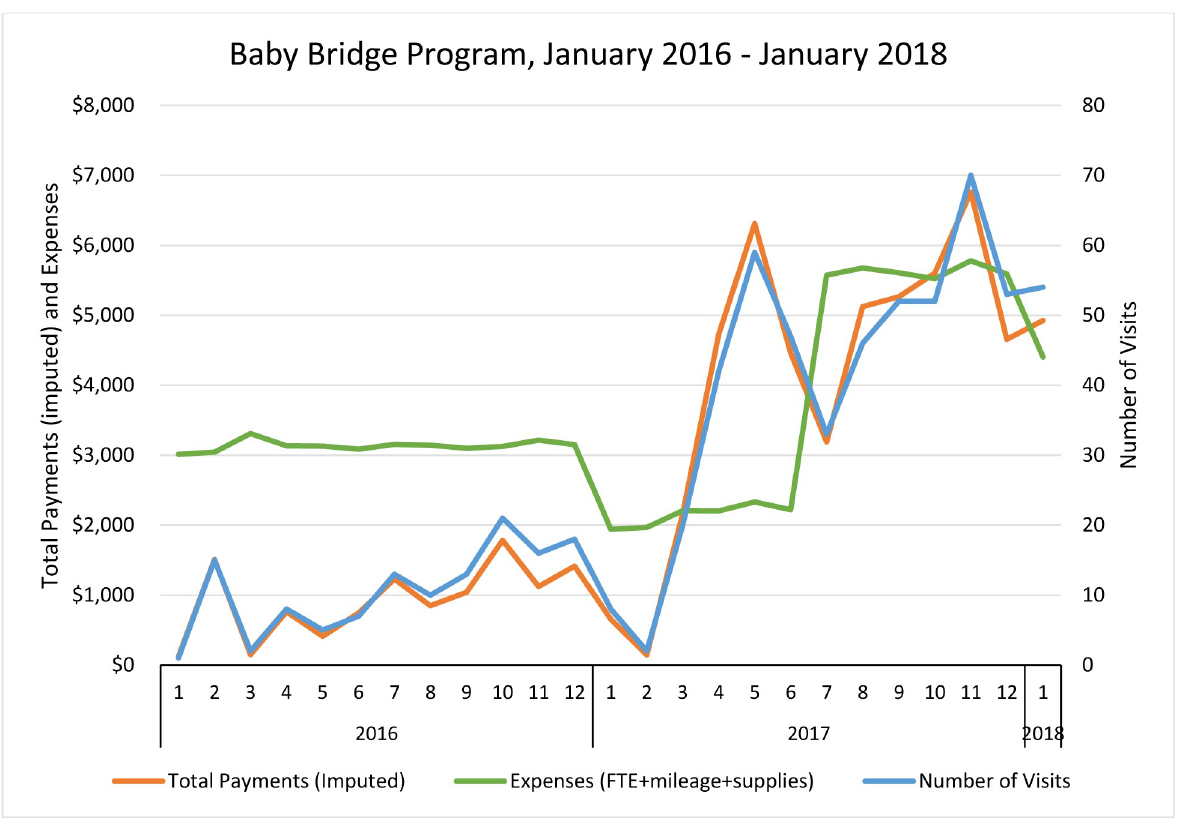
Fig 1. Payments, expenses, and number of Baby Bridge visits from January 2016 to January 2018. The primary Baby Bridge therapist, which has the largest associated costs related to Baby Bridge program expenses, worked 50% of a full time equivalent (FTE) position to evaluate and provide treatment through the Baby Bridge program for the first 11 months. There was a transition in the Baby Bridge therapist one year into programming, with the previous one phasing out and a new therapist phasing in and contributing 33% effort from 1/1/17 to 6/30/17, as she built a caseload. The new Baby Bridge therapist increased her time with the program to 95% FTE from 7/1/17-12/31/17.